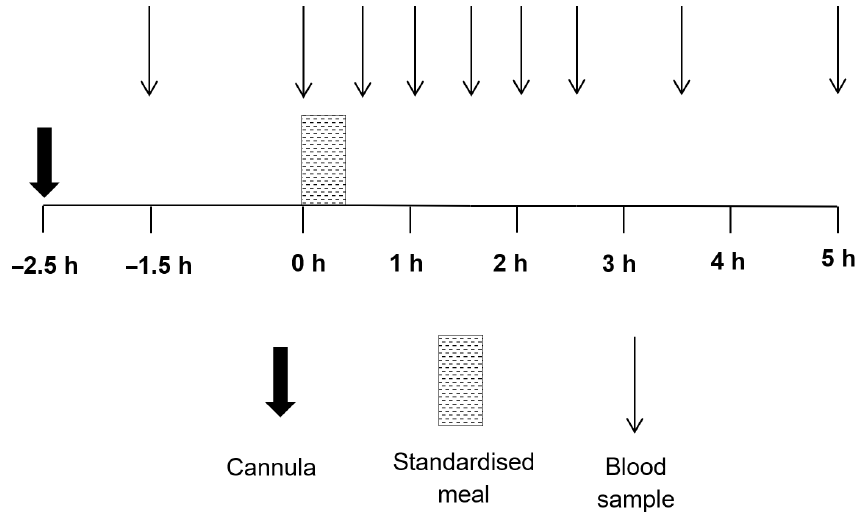
Figure 1. Schematic of trial. Abbreviations: h, hour.